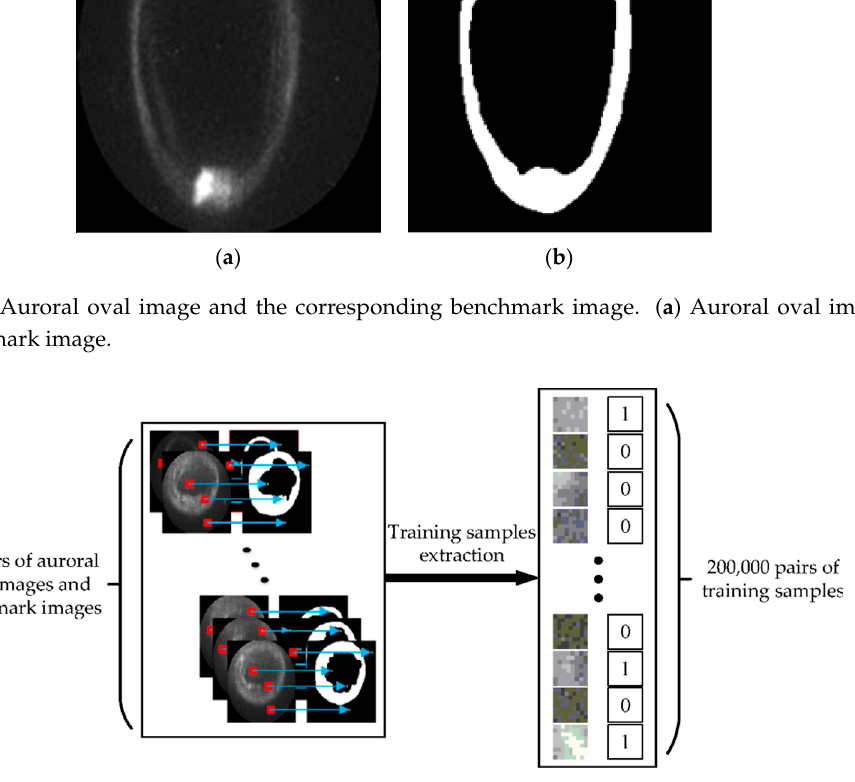
Figure 8. Auroral oval image and the corresponding benchmark image. ( a ) Auroral oval image. ( b ) Benchmark image.